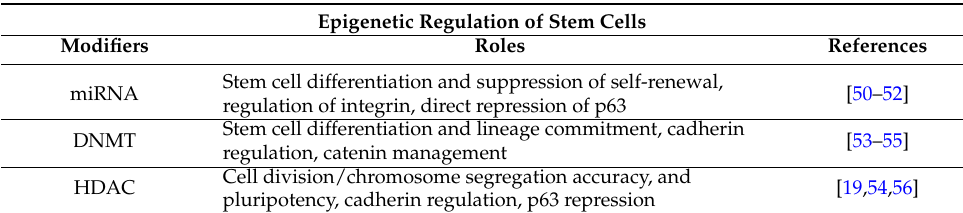
Table 2. Epigenetic modifiers and their roles in stem cell regulation. DNMT: DNA methyltransferase; HDAC: histone